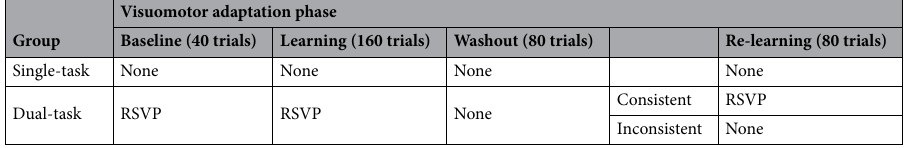
Table 1. The secondary (RSVP) task performed in each group throughout each visuomotor adaptation